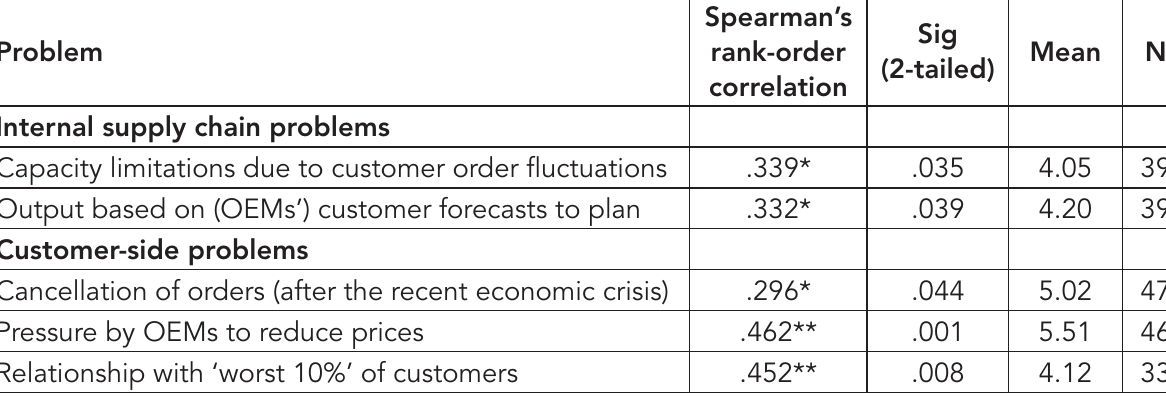
Table 2: Significant correlation between purchasing price of